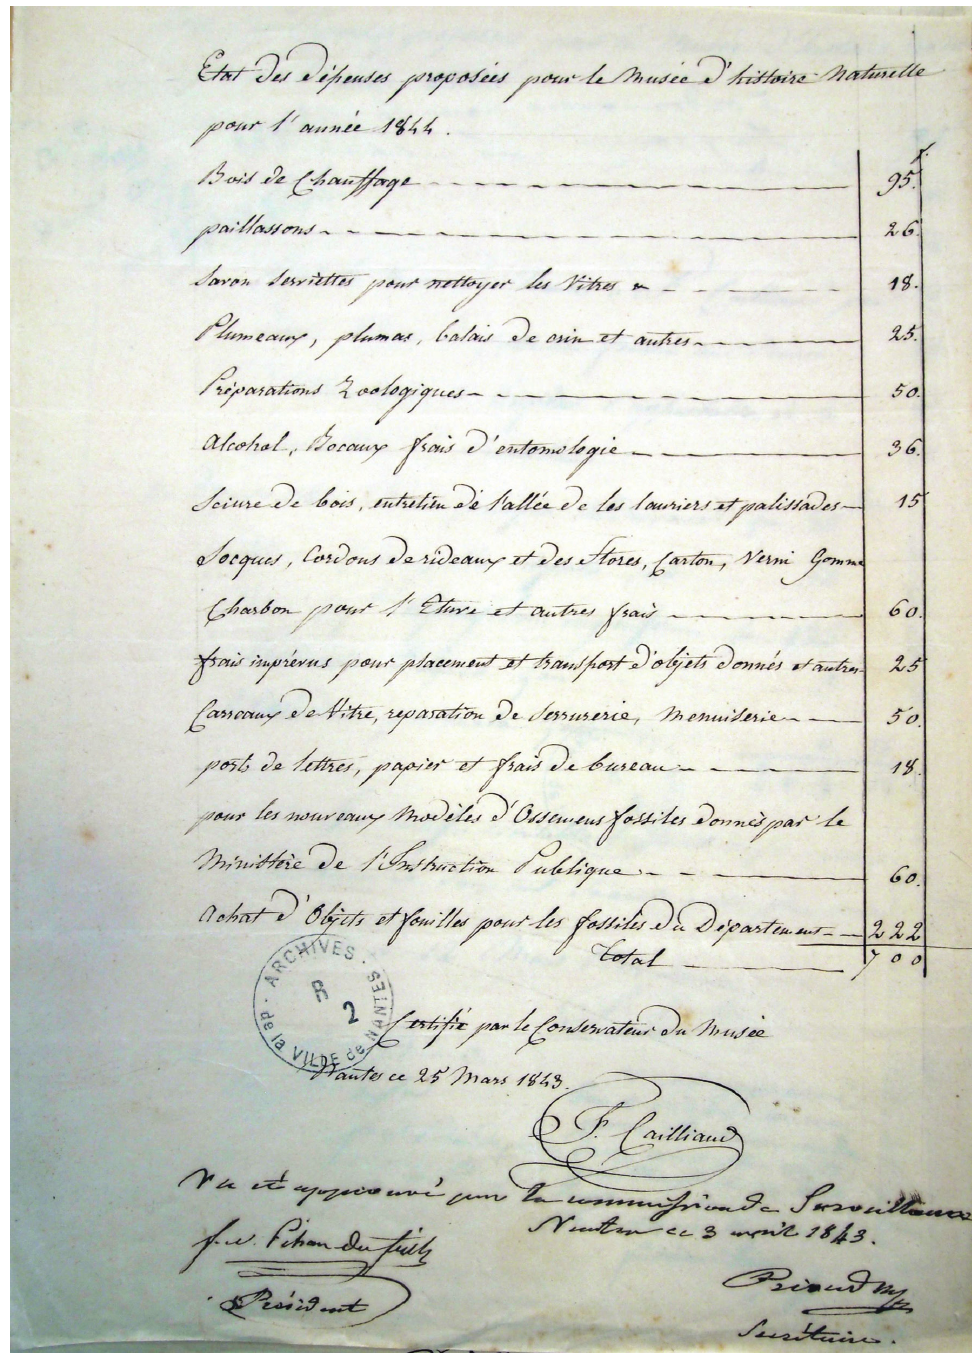
Figure 1: “Statement of proposed expenses for the Natural History Museum in 1844.” AMN, 2R565, 25 March